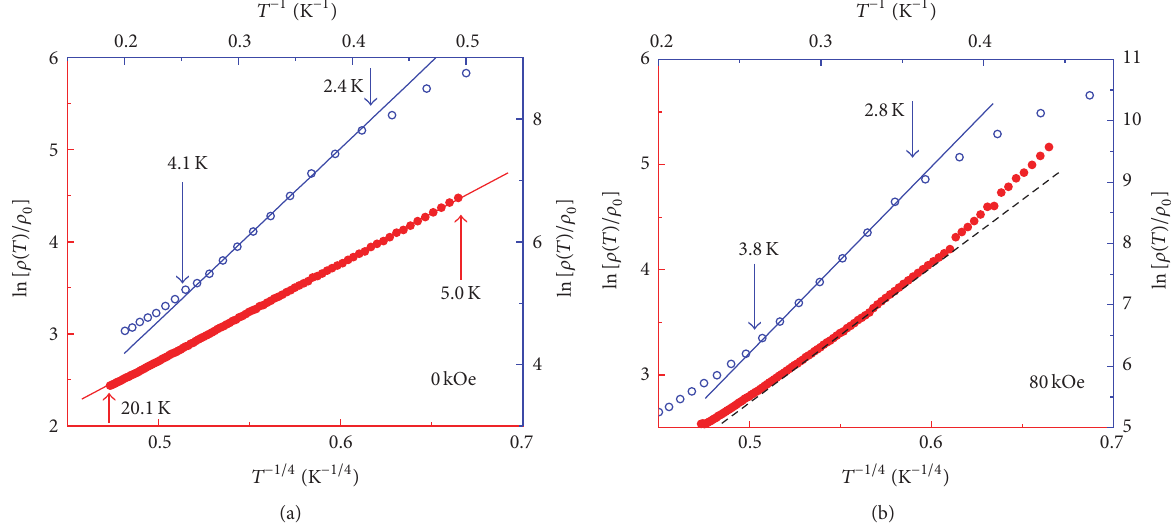
Figure 2: (a) ln 𝜌 versus 𝑇 −1/4 (red symbols), left and bottom red axis. ln 𝜌 versus 𝑇 −1 (blue symbols), right and upper blue axis. Solid lines are the result of the best linear fit in these coordinates. Data are for 𝐻 = 0 . (b) ln 𝜌 versus 𝑇 −1/4 (red symbols), left and bottom red axis. ln 𝜌 versus 𝑇 −1 (blue symbols), right and upper blue axis. Solid blue line is the result of the best linear fit in these coordinates. Dashed black line is tangent to the experimental data. Data are for 𝐻 = 80 kOe.